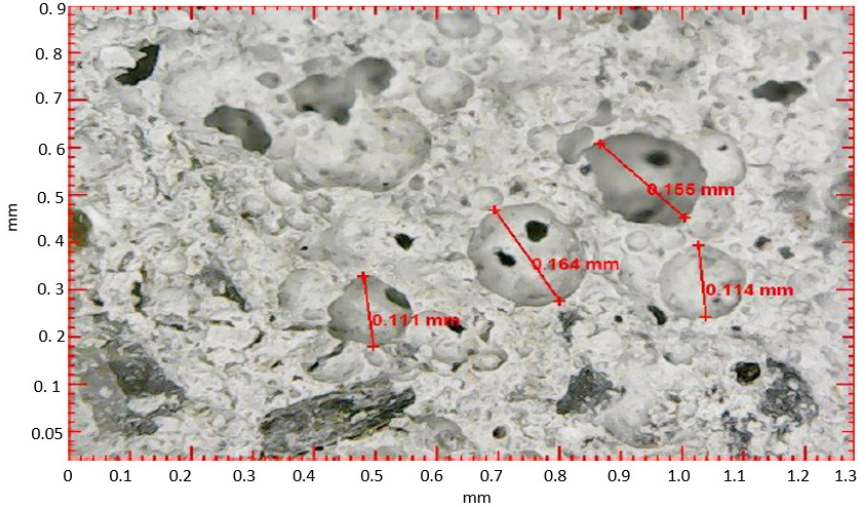
Figure 3. Structures of the air void system of FC.